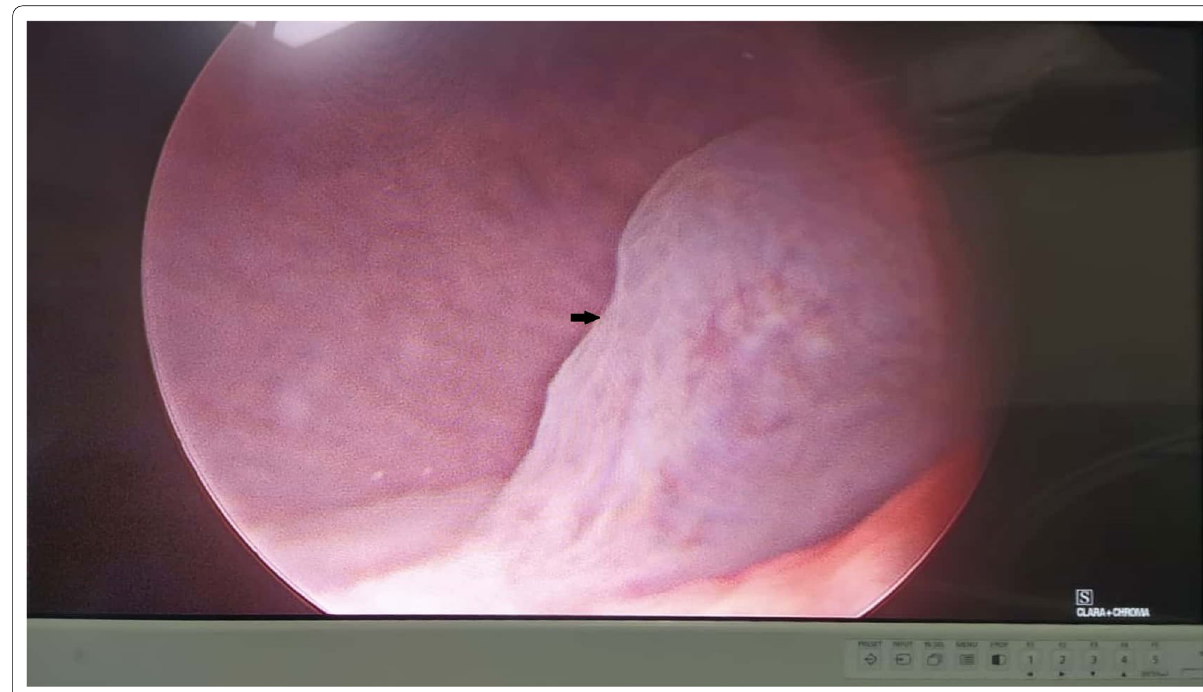
3 cm arising from inferoposterior and left lateral wall. ×